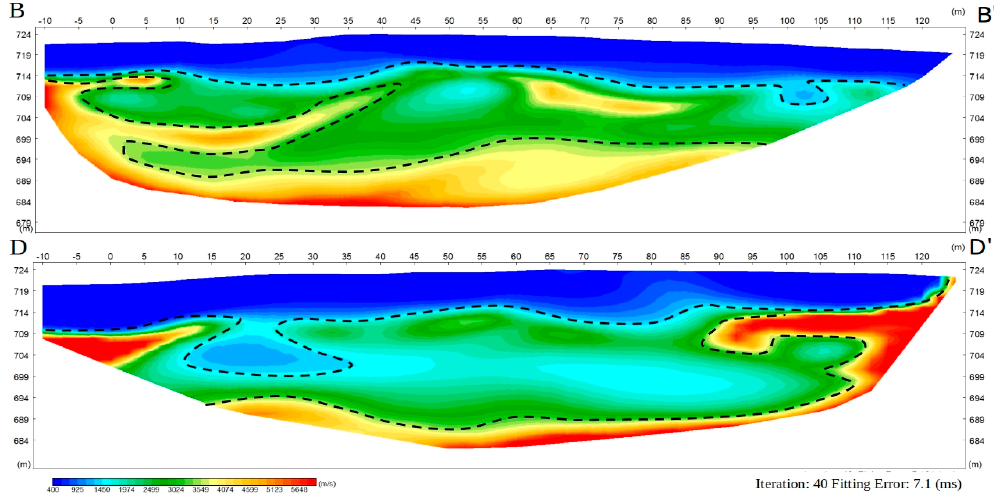
Figure 13. P-wave velocity tomographic models at the D - D’ and B - B’ seismic lines. The black dotted lines show the thickness of claystone (perched aquifer).